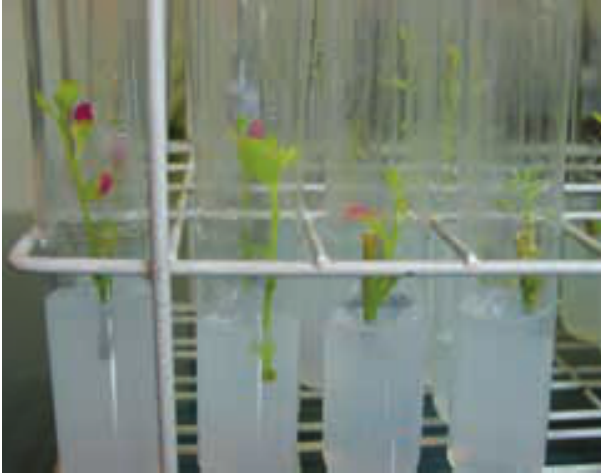
Fig. 1: Initial culture of Atriplex halimus L.